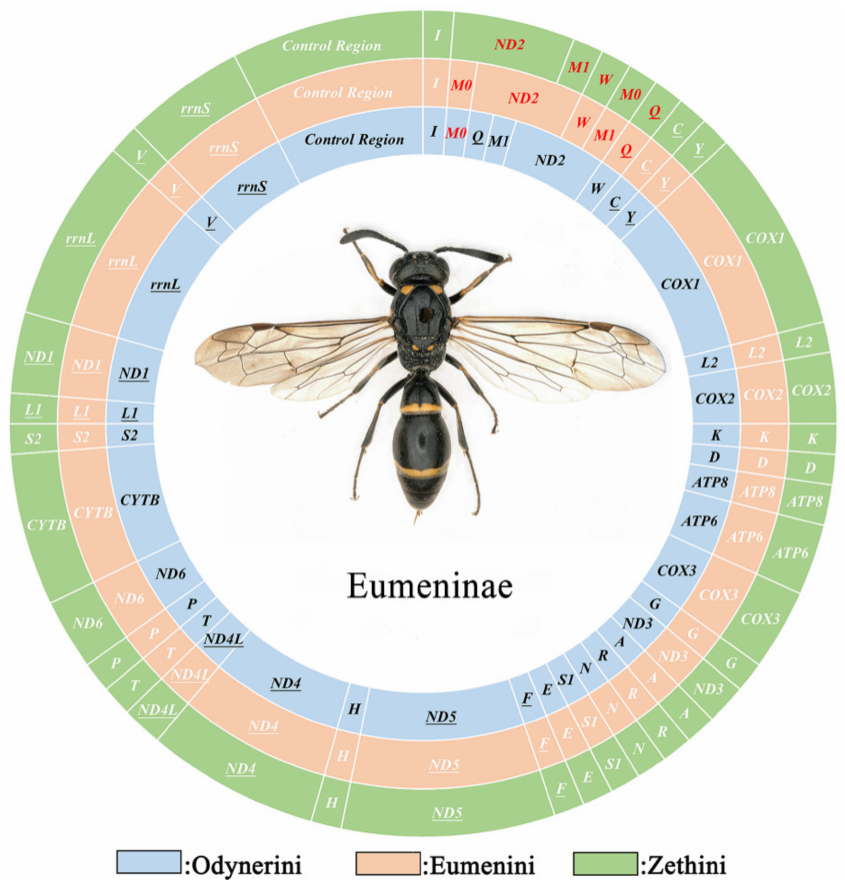
Figure 1. The mitochondrial genomes of Eumeninae. Circles of different colors indicate different tribes of Eumeninae. The red gene means its position is inconsistent with the ancestor insect. Compared with other Vespidae, there are 26 in total in the 52 newly assembled mi- togenomes of Eumeninae containing two trnM genes which are highly similar, with 51.86% ( Eumenes tripunctatus ) to 90.65% ( Pseumenes nigripectus ) sequence identities (Figure S2). The substitutions between trnM0 and trnM1 are identified in the Amino Acid acceptor (AA) arm, T ψ C (T) arm, Variable (V) loop, Anticodon (AC) arm, and the dihydorouridine (DHU) arm (Figure 2). The positions of trnM0 and trnM1 are different: some are connected